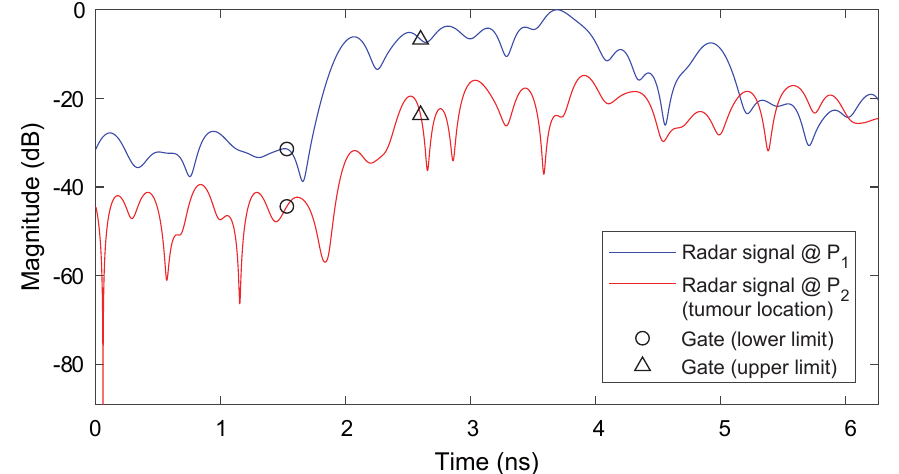
Figure 3. Comparison of UWB radar signals measured at two different positions on the breast as illustrated in Figure 2b. It can be observed that a difference in time of arrival and signal amplitude occurs. Attenuation and time delay are much higher for the tumor location given by a higher conductivity of the malignant tissue and a higher relative permittivity (i.e., smaller wave speed). The time-domain gatings are illustrated that show the signal regions used for RMS